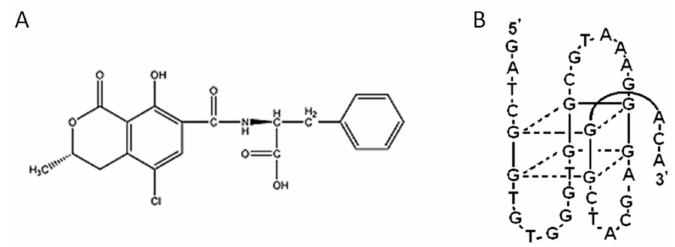
Figure 1. The chemical structure of OTA ( A ) and its aptamer ( B